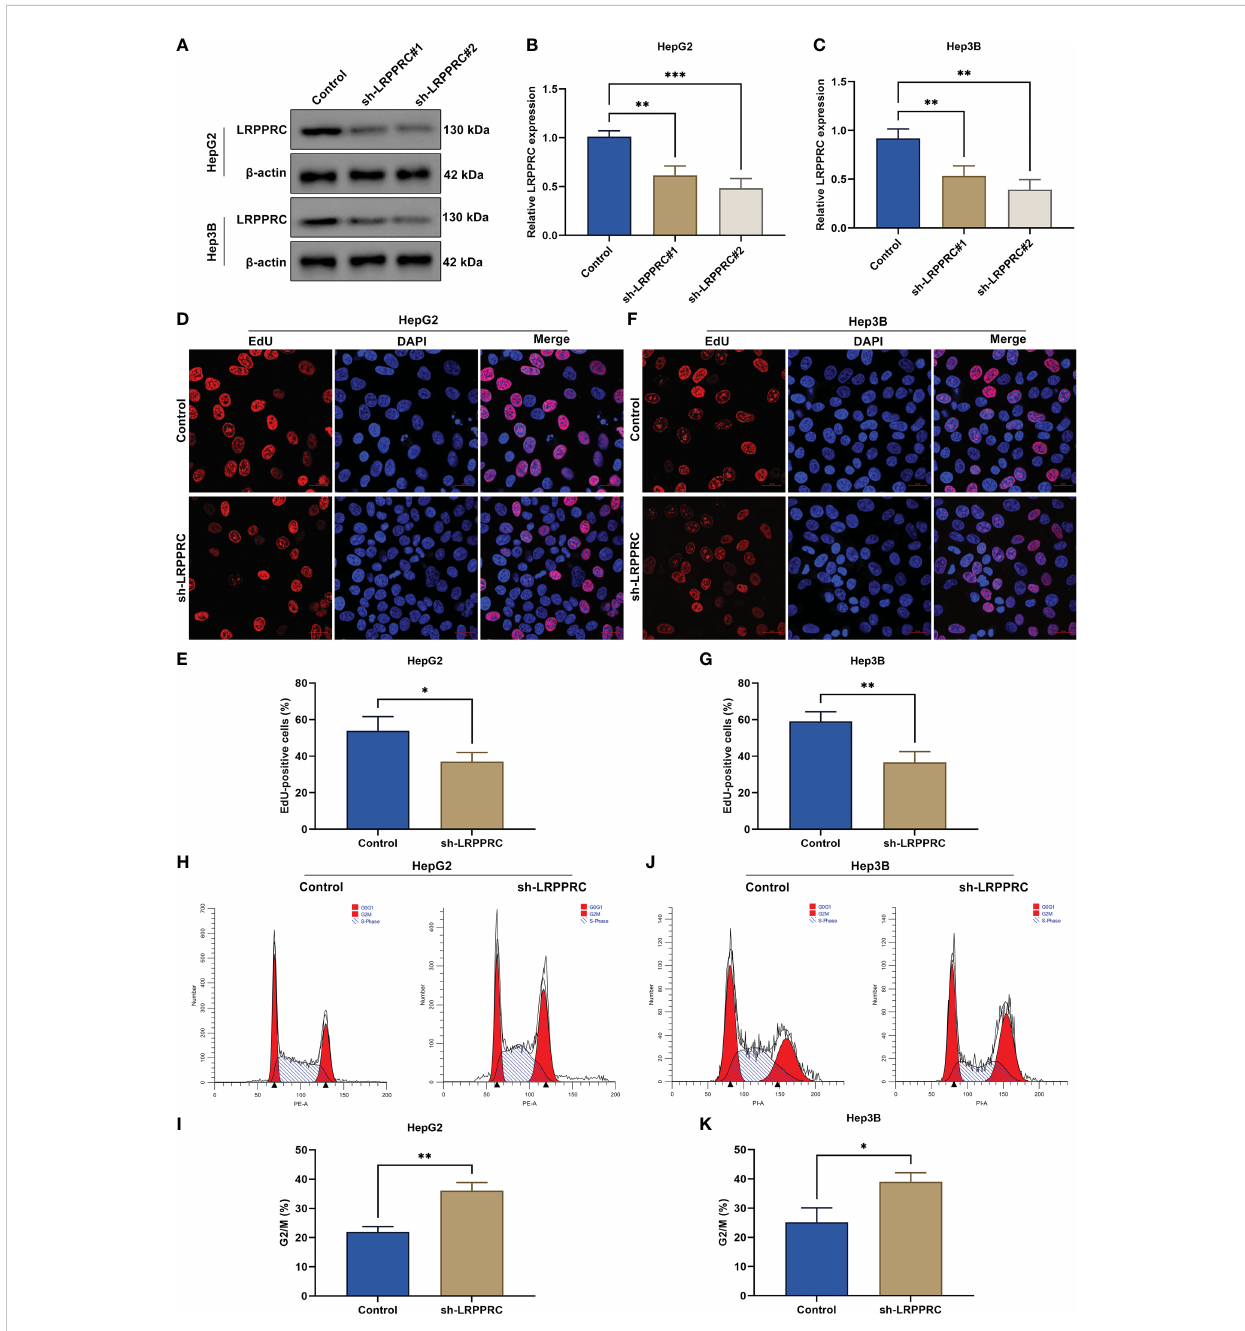
FIGURE 2 Leucine rich pentatricopeptide repeat containing (LRPPRC) suppression mitigates proliferative capacity as well as delays cell cycle progression in hepatocellular carcinoma (HCC) cells. (A – C) Immunoblotting of LRPPRC expression in HepG2 and Hep3B cells after LRPPRC was knockout. (D – G) EdU staining for the evaluation of proliferative ability of HCC cell lines with LRPPRC de fi ciency. Bar, 20 m m. (H – K) Flow cytometric analysis for the cell cycle distribution of LRPPRC-knockout HCC cells. * p < 0.05; ** p < 0.01; *** p <